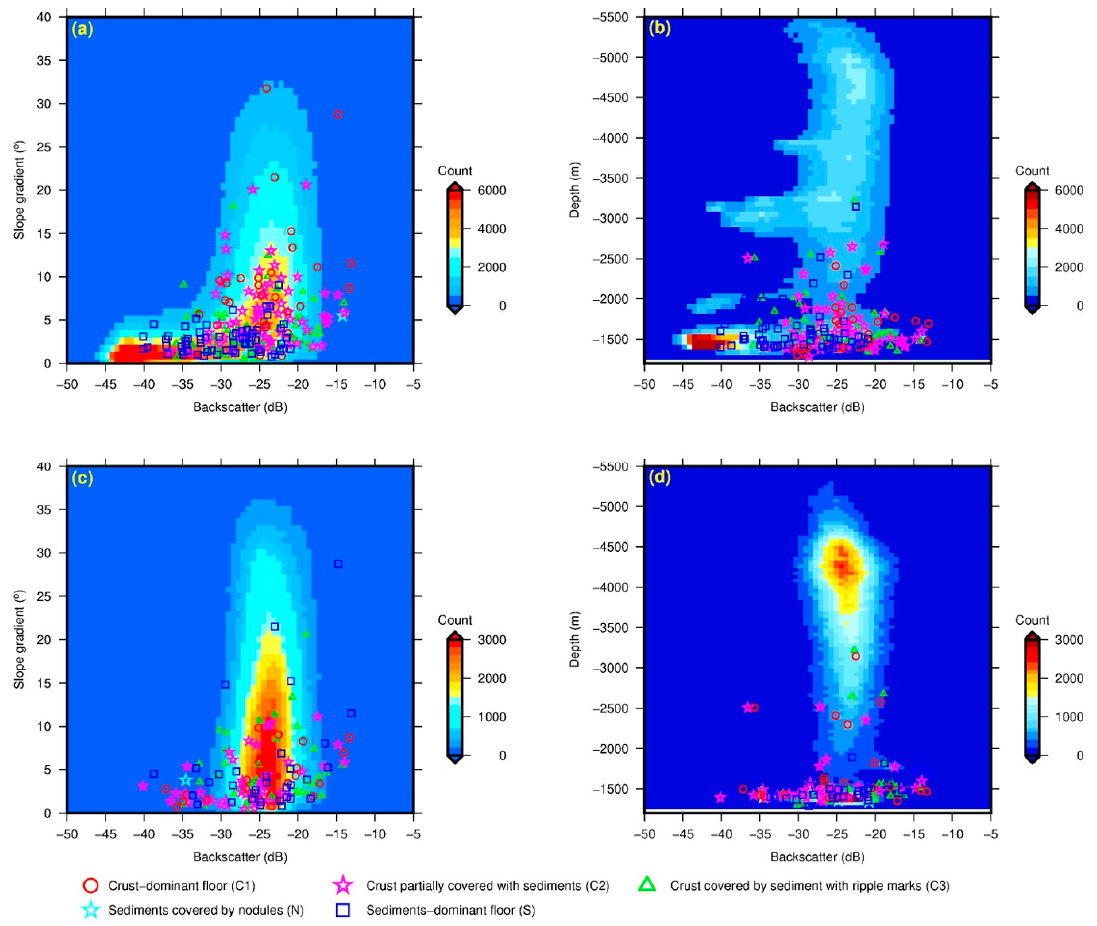
Figure 10. Density plots of backscatter versus slope gradients illustrate the shipboard MBES data of ( a ) Type 1 ′ s seamounts and ( c ) Type 2 ′ s seamounts. Other density plots of backscatter versus depth show the distribution of MBES data of ( b ) Type 1 ′ s seamounts and ( d ) Type 2 ′ s seamounts. Overlaid on density plots are the observed seafloor types extracted from DCS tracks corresponding to the seabed characterizations.